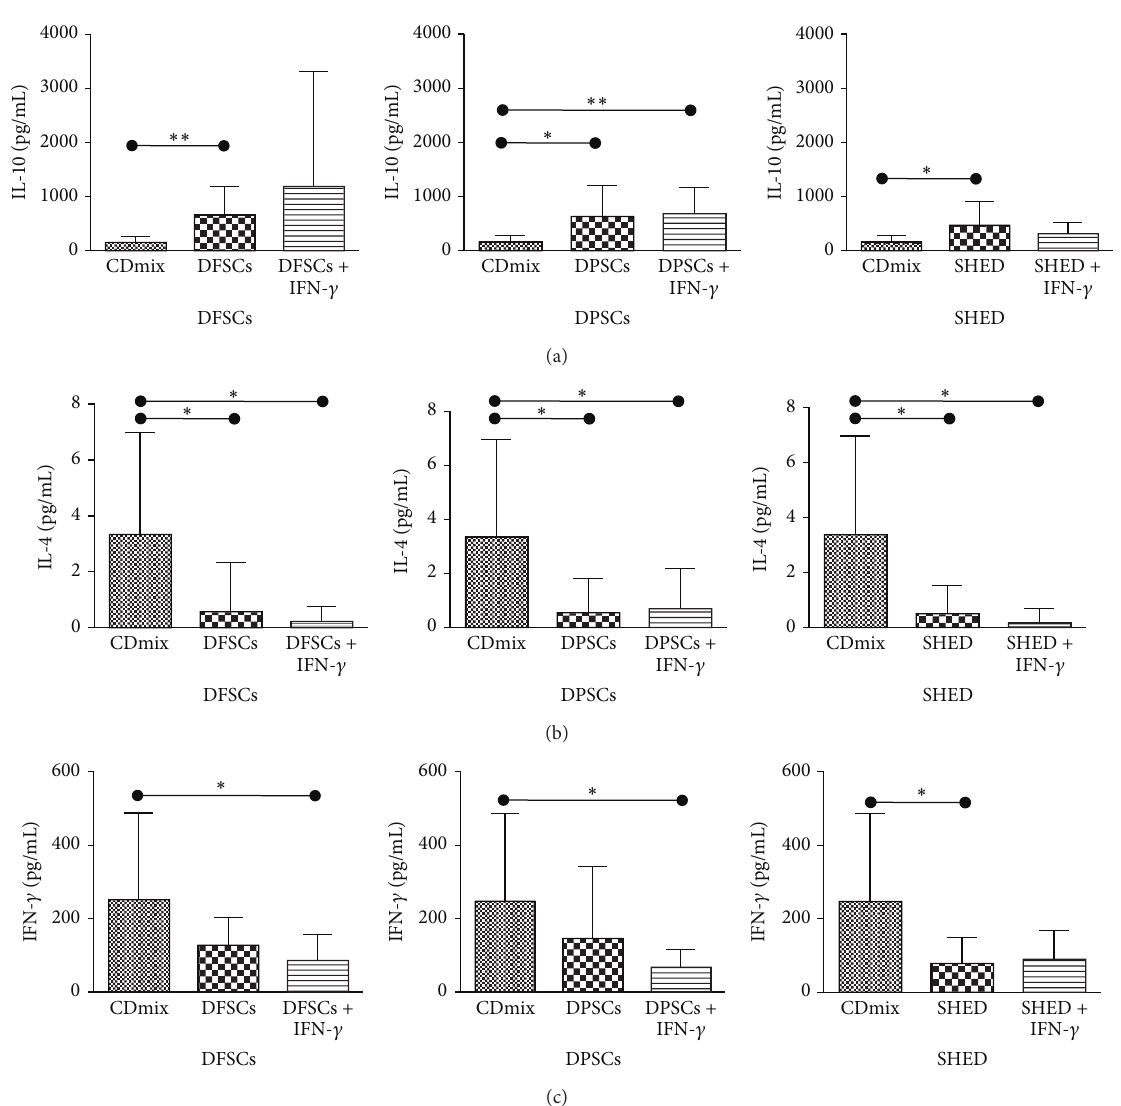
Figure 9: The immunoregulatory effects of SHED, DPSCs, and DFSCs on the expression of IL-10, IL-4, and IFN- 𝛾 cytokines in lymphocytes. (a) Induced effects of SHED, DPSCs, and DFSCs on the expression of IL-10 cytokines in lymphocytes. (b) Inhibited effects of SHED, DPSCs, and DFSCs on the expression of IL-4 cytokines in lymphocytes. (c) Inhibited effects of SHED, DPSCs, and DFSCs on the expression of IFN- 𝛾 cytokines in lymphocytes ( ∗ 𝑃 < 0.05 , ∗∗ 𝑃 < 0.01